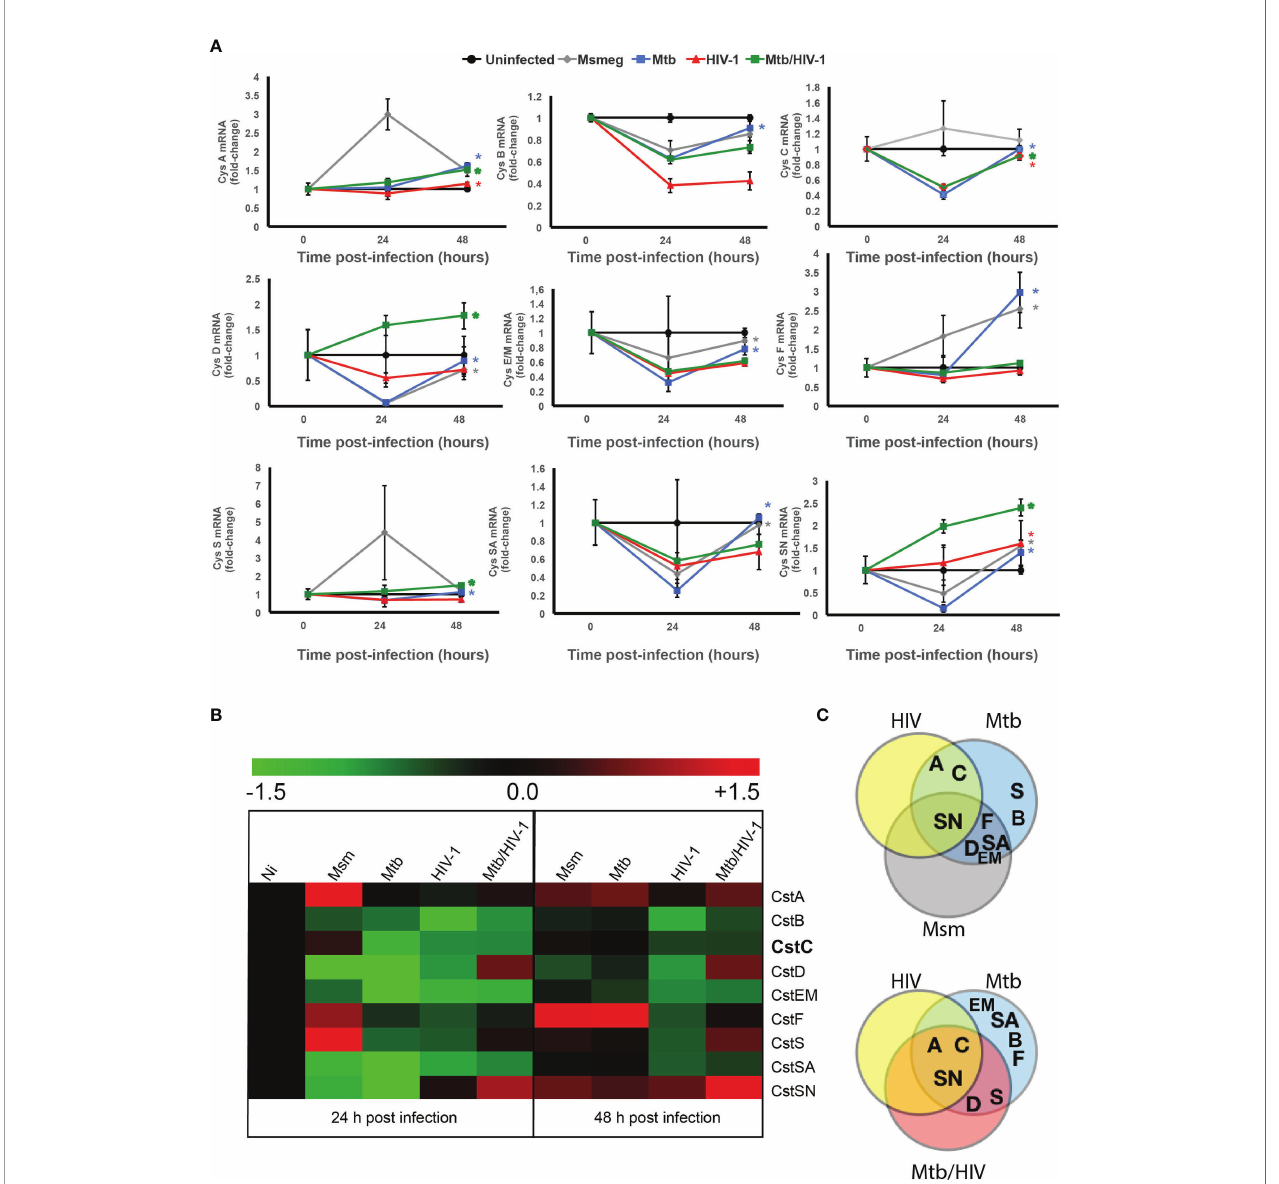
FIGURE 2 | Cystatins are differentially regulated during mono-infection with Mtb or HIV, or coinfection with pathogens. (A) Gene expression kinetics of cystatins in Mø infected with Mtb or HIV, or coinfected with both pathogens, in comparison with the infection with Mycobacterium smegmatis for 24 and 48 h. Values are depicted relative to uninfected control and were previously normalized to GAPDH expression. Data are represented as the mean fold change per sample ± standard error. Statistical signi fi cance displayed refers to the values at 48 h relative to 24 h p.i. (* p ≤ 0.01; n = 3). (B) Heatmap of qRT-PCR quanti fi cation of mRNA obtained from Mø after 24 and 48 h of infection. Values are depicted as log2 gene expression relative to uninfected Mø. (C) Venn diagram of the con fi rmed “ hits ” that exhibit signi fi cantly increased gene expression from 24 to 48 h p.i. Mtb, Mycobacterium tuberculosis ; Mø,